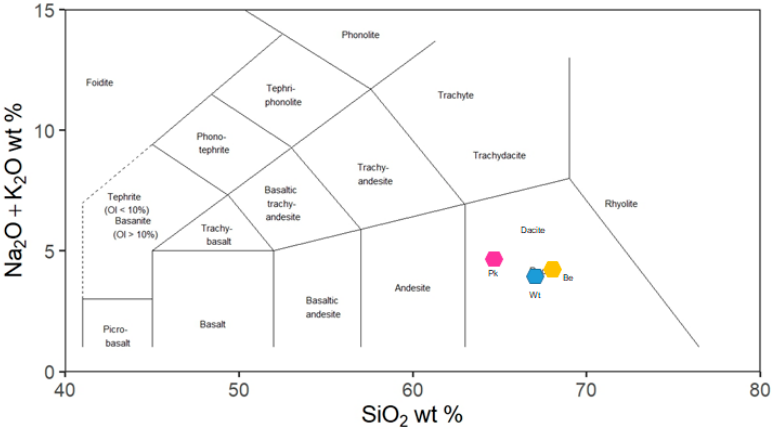
Figure 6. TAS classification of the three ignimbrites.